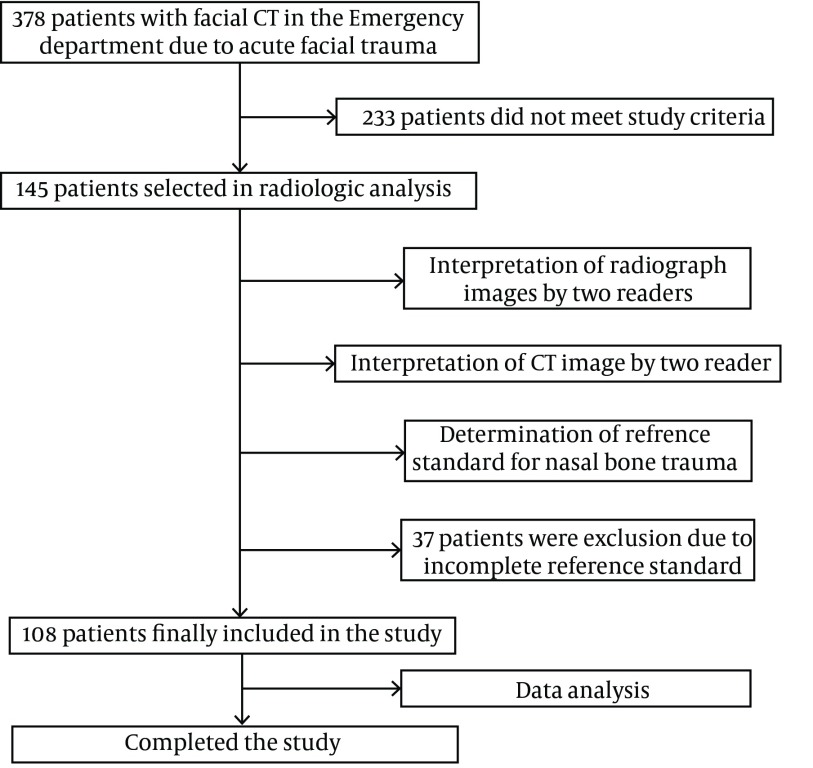
 A diagram presenting enrollment of the studied patients and the study algorithm.